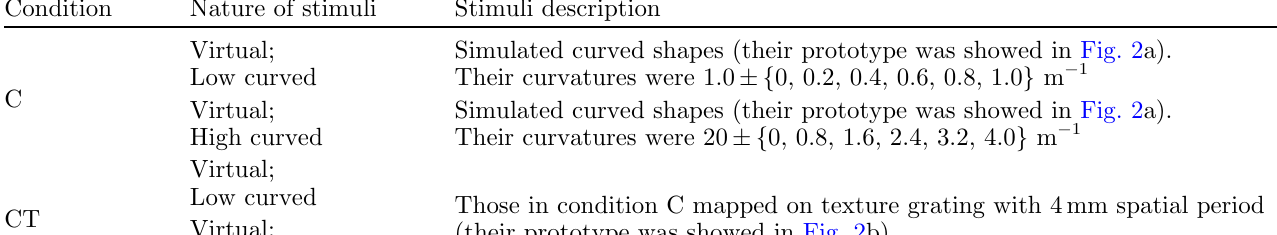
Table 2. Description of conditions and stimuli in Exp. 1. Condition Nature of stimuli